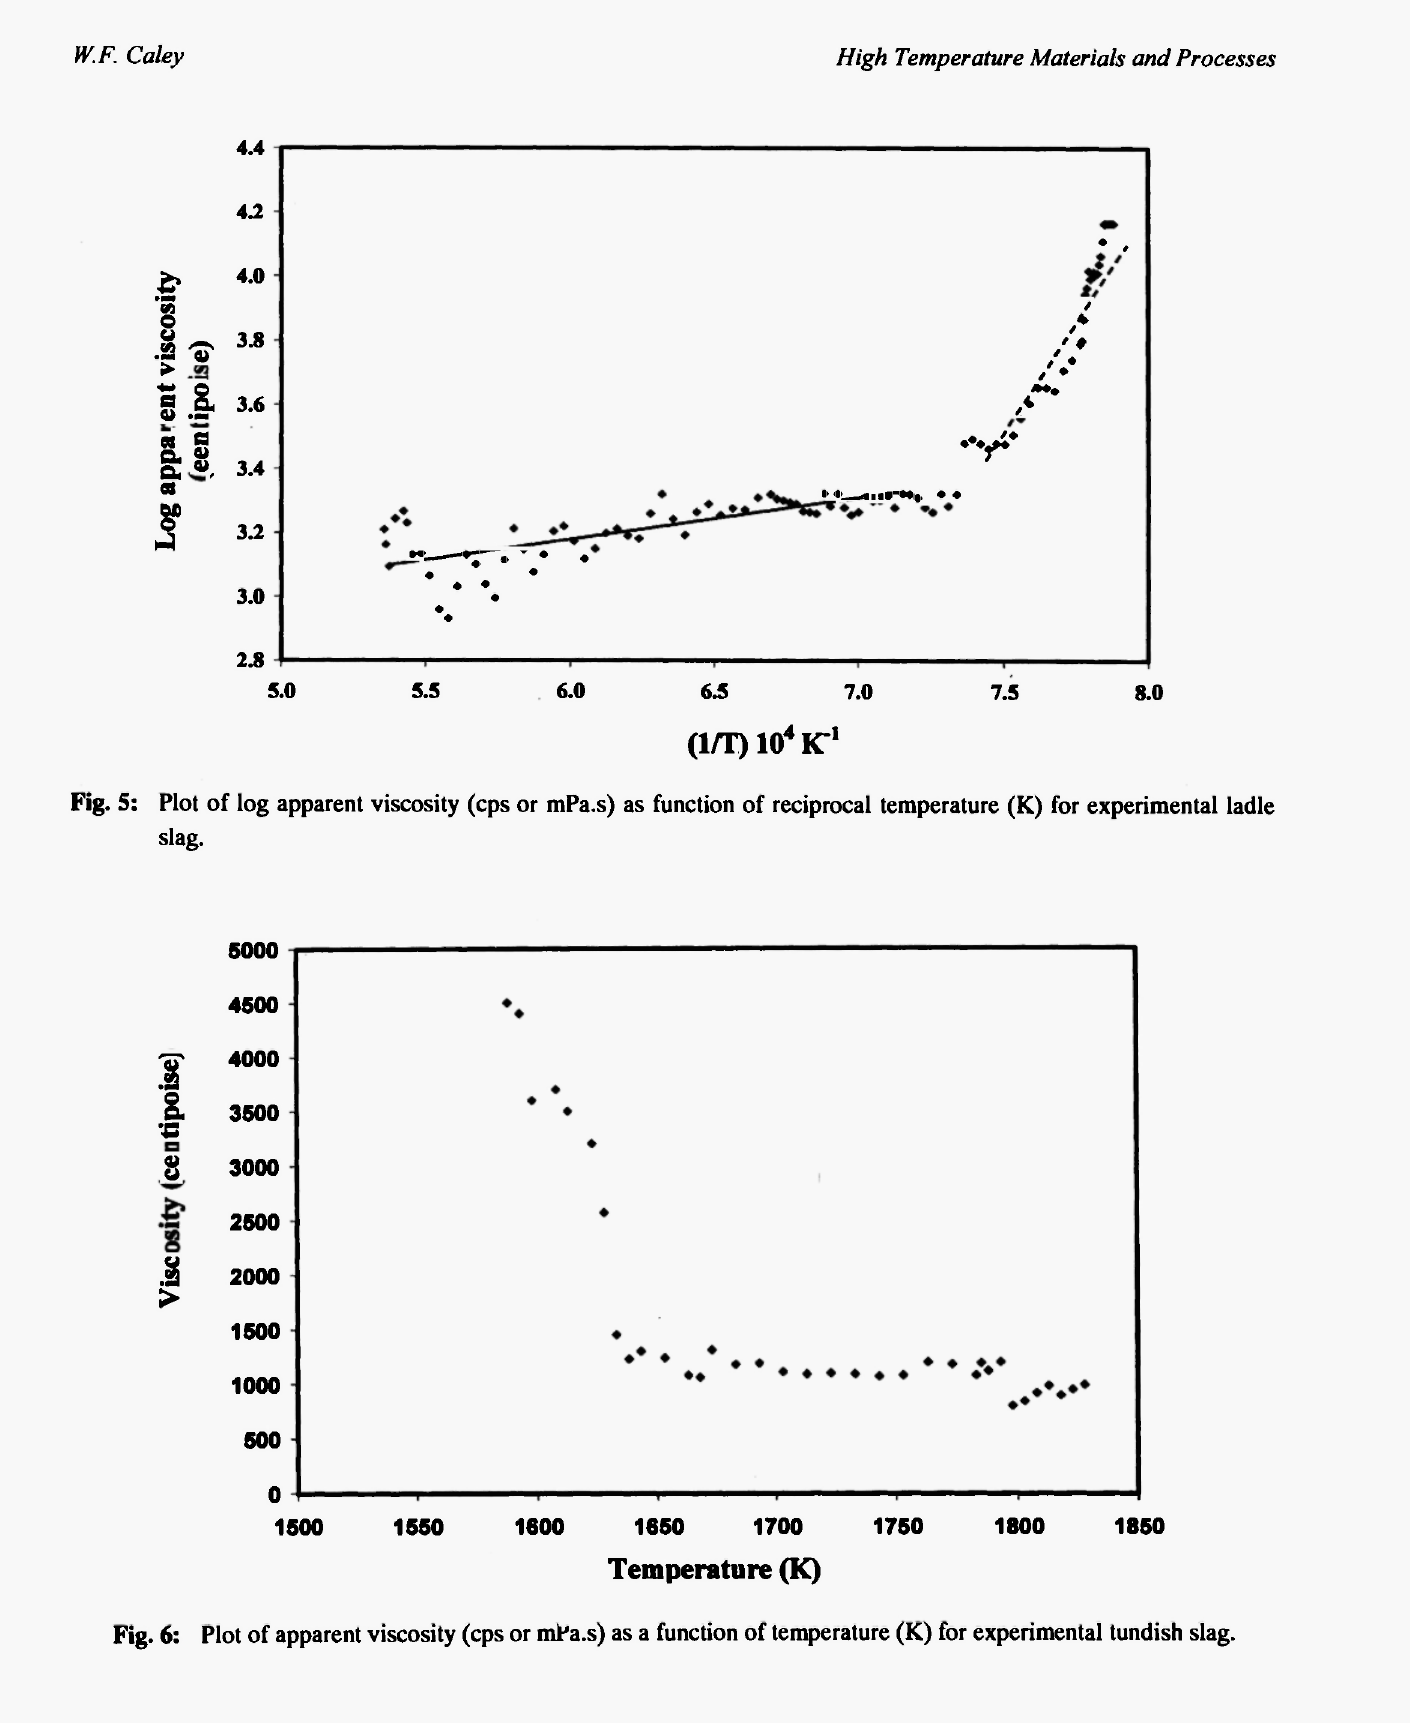
Fig. 6: Plot of apparent viscosity (cps or mPa.s) as a function of temperature (K) for experimental tundish slag.